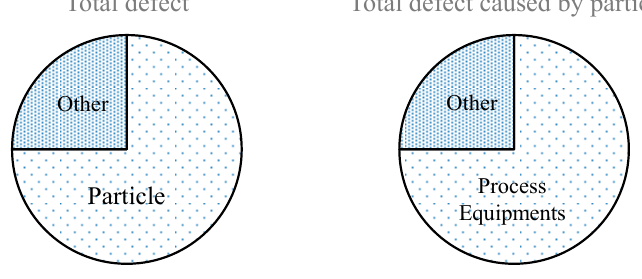
Figure 3. Distribution of defects in a semiconductor manufacturing process.